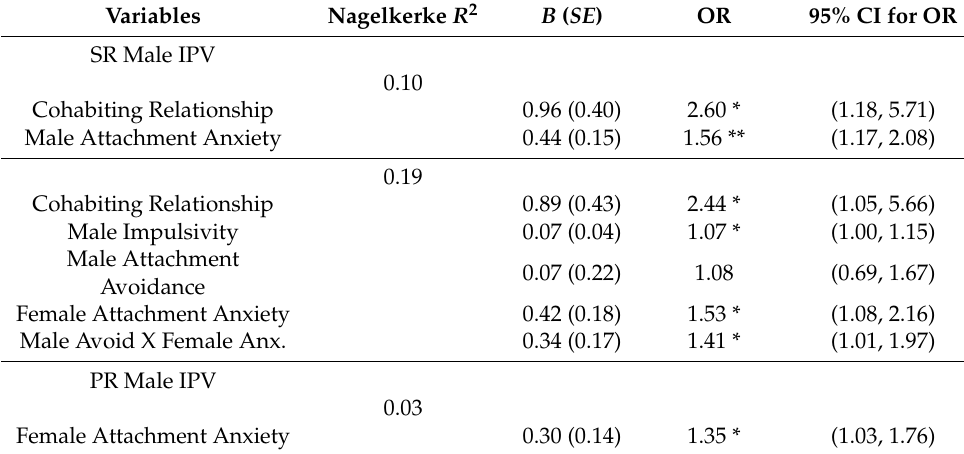
Table 8. Binary logistic regression models: predictors of self-reported and partner-reported male physical